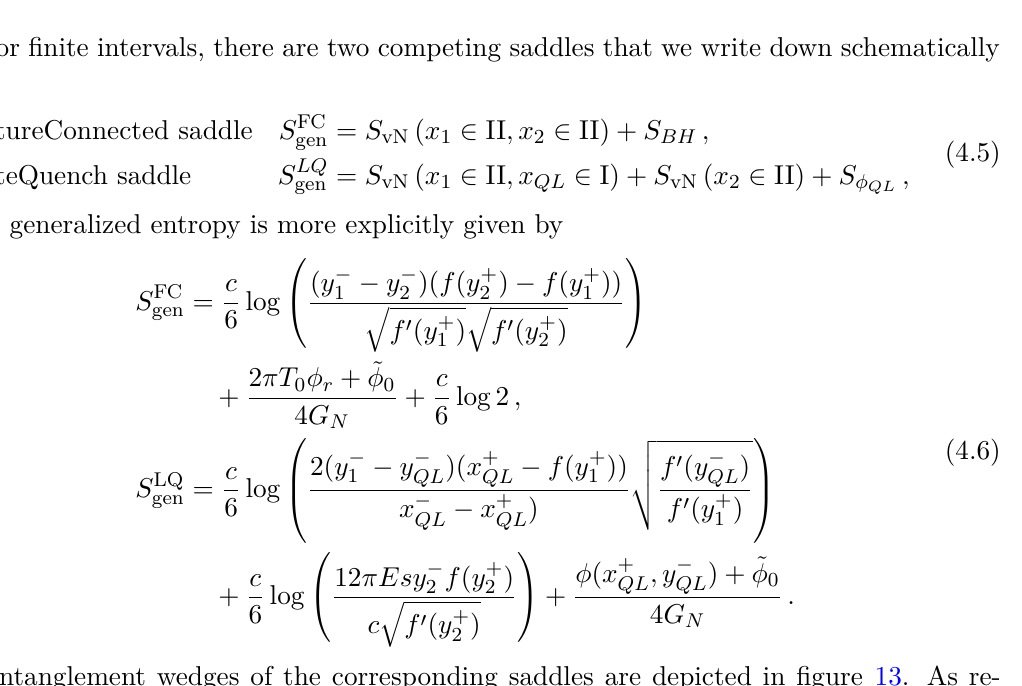
Figure 13. A sketch of the entanglement wedges for the different phases the entanglement entropy for QM L +finite segment during late